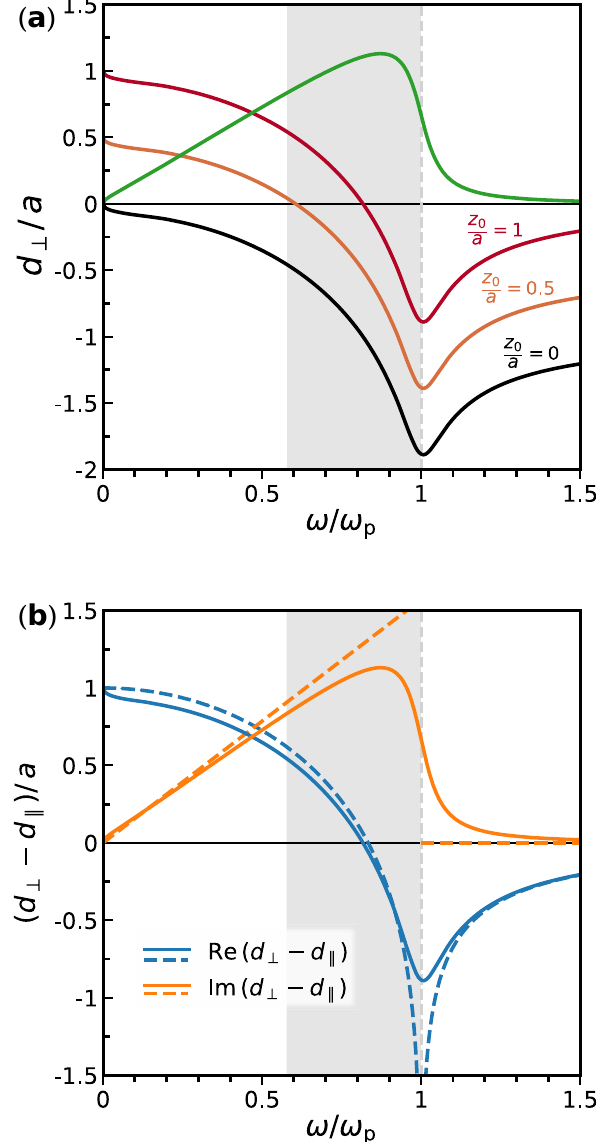
Figure 2: Feibelman d -parameters in the LRA for a jellium–vacuum = 1) characterized by a smooth electron-density interface ( 𝜀 + = 𝜀 d profile. (a) Real, Re d ⊥ (black, light-red, red), and imaginary part, Im d ⊥ (green) [Eq. (11a)] of the d -parameters for the electron-density ∕ a (whose effect is a profile described in Eq. (9) with varying z 0 simple vertical shift of the Re d ⊥ curve); we assume a Drude bulk = 0 . 1. (b) Effective surface-response damping of Γ = 𝛾 ∕ 𝜔 p ≡ d − d function d ⊥ ∥ [from Eq. (11)]. The dashed curves depict eff the result in the lossless case [62] [using Eqs. (11b) and (12)]. The grey-shaded region indicates the frequency window supporting semiclassical localized plasmon resonances in metallic